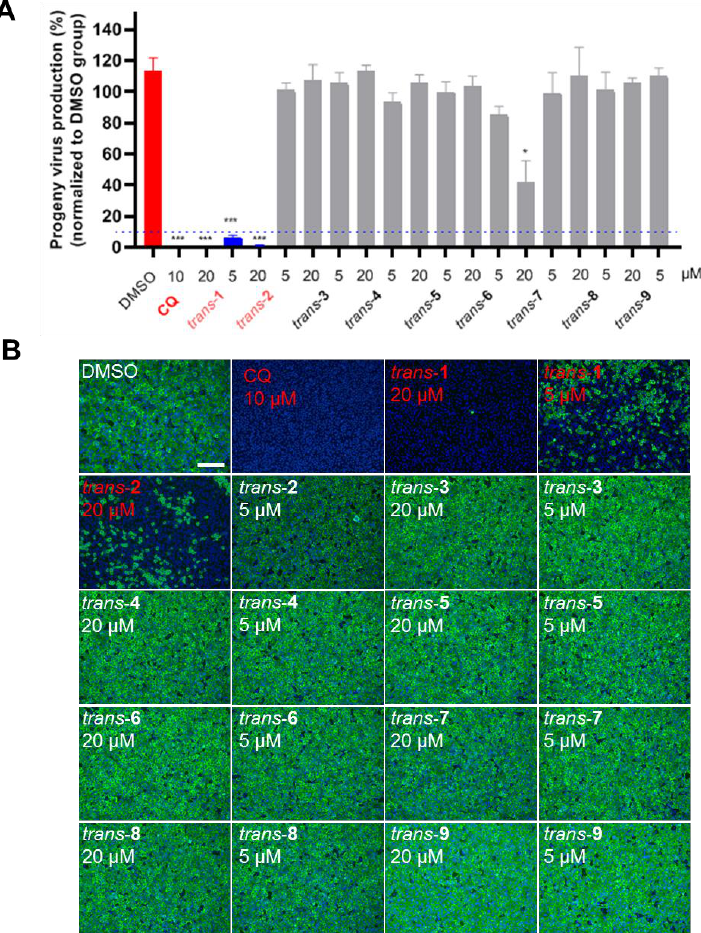
Figure 2. Screening for compounds with anti-SARS-CoV-2 activity. Vero E6 cells were treated with 20 µ M or 5 µ M of each compound and infected with SARS-CoV-2 (MOI = 0.05). ( A ) The supernatant was collected 24 h post-infection (hpi), and virus production was quantified using qRT-PCR. trans - 1 and trans - 2 were labeled in a red font, as at least one of the working concentrations decreased the viral load by ≥ 90% (blue dashed line). Vehicle (DMSO) and chloroquine (10 µ M) treatments were used as a negative and positive control, respectively. Each concentration of all compounds was performed in three replicates. A t test was performed to show the differences between each group and DMSO control. * indicates p < 0.05; *** indicates p < 0.001. ( B ) IFA results of screening for compounds with anti-SARS-CoV-2 activity. The infected cells were fixed with 4% PFA, and an immune staining of a viral NP was used to show the viral positive cells. Four treatments, i.e., 10 µ M CQ, 20 µ M trans - 1 , 5 µ M trans - 1 , and 20 µ M trans - 2 , inhibited viral infection obviously, and they are labeled in a red font. The scale bar is 400 μm.